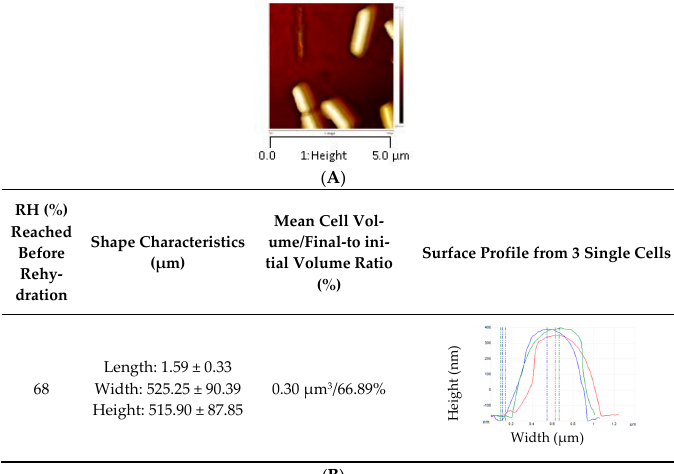
Figure 4. L. monocytogenes EGDe morphology observed by AFM after dehydration and rapid rehy- dration in PBS. Cells were dehydrated in PBS at 68% RH for 3 h at 25 °C. AFM height images (with a Z-scale approx. 250 nm) of cells dehydrated at ( A ) 68% RH followed by rapid rehydration. ( B ) L. monocytogenes EGDe morphology characteristics. Cells were immobilized on a glass slide coated with poly- D -lysine.